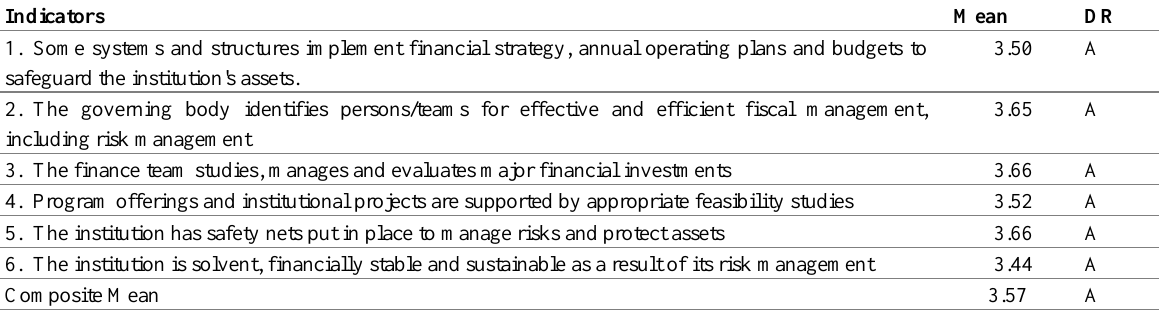
Table 4: Corporate Governance in terms of Awareness and Management of